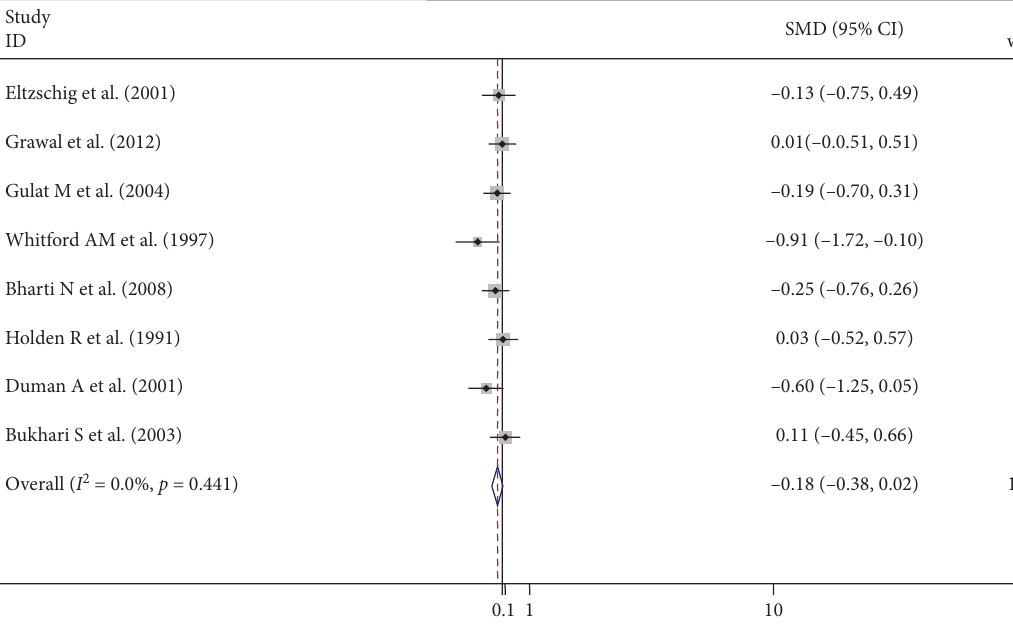
Figure 2: Meta-analysis of IOP changes before insertion of LMA and ETT